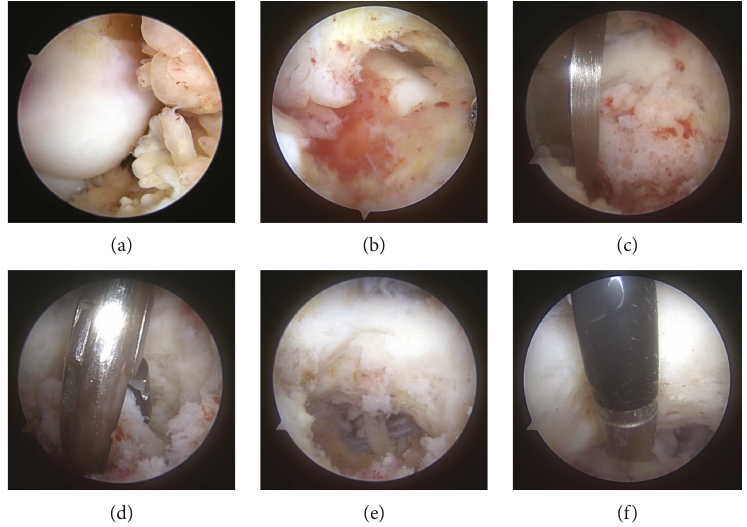
Figure 4: Arthroscopic fi ndings. Proliferated synovial tissues were shown via anteromedial (a) and posterolateral (b) portals. The lesion was excised as an en bloc specimen (c, d, e). The margin was carefully treated to eliminate all traces of the tumor (f).